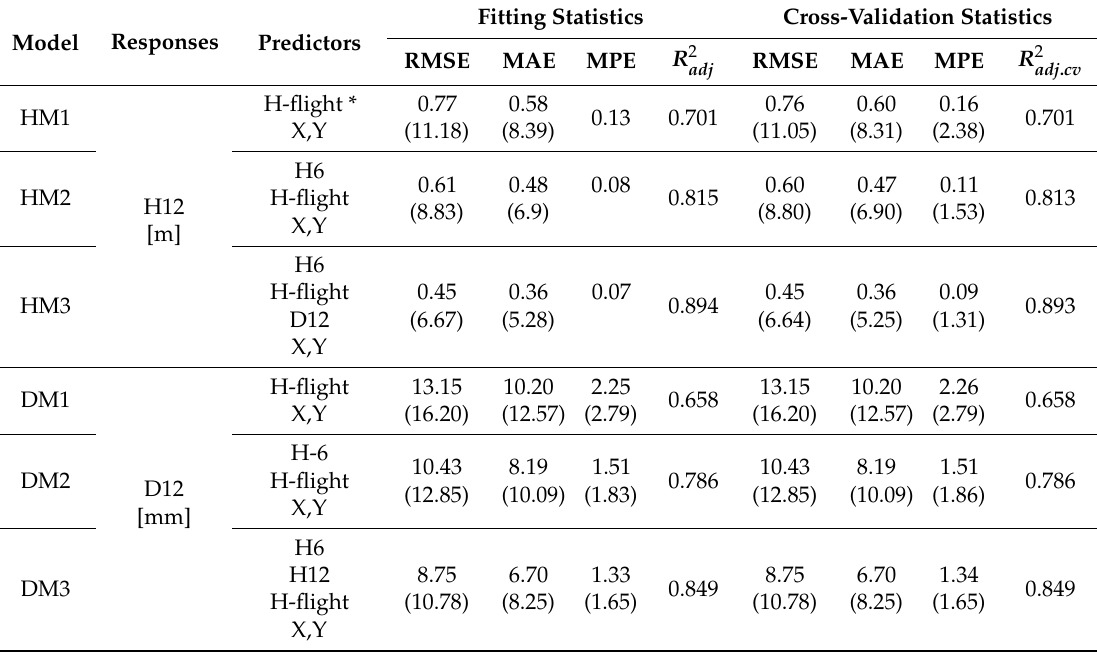
Table 1. Goodness-of-fit statistics for the hierarchical generalized additive (HGAM)